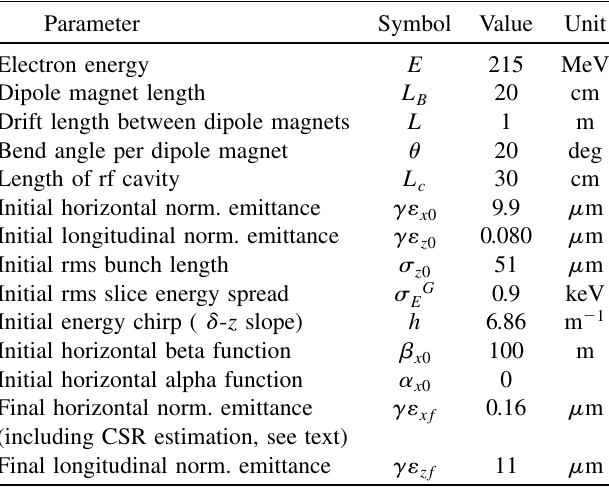
TABLE II. Emittance exchange simulation